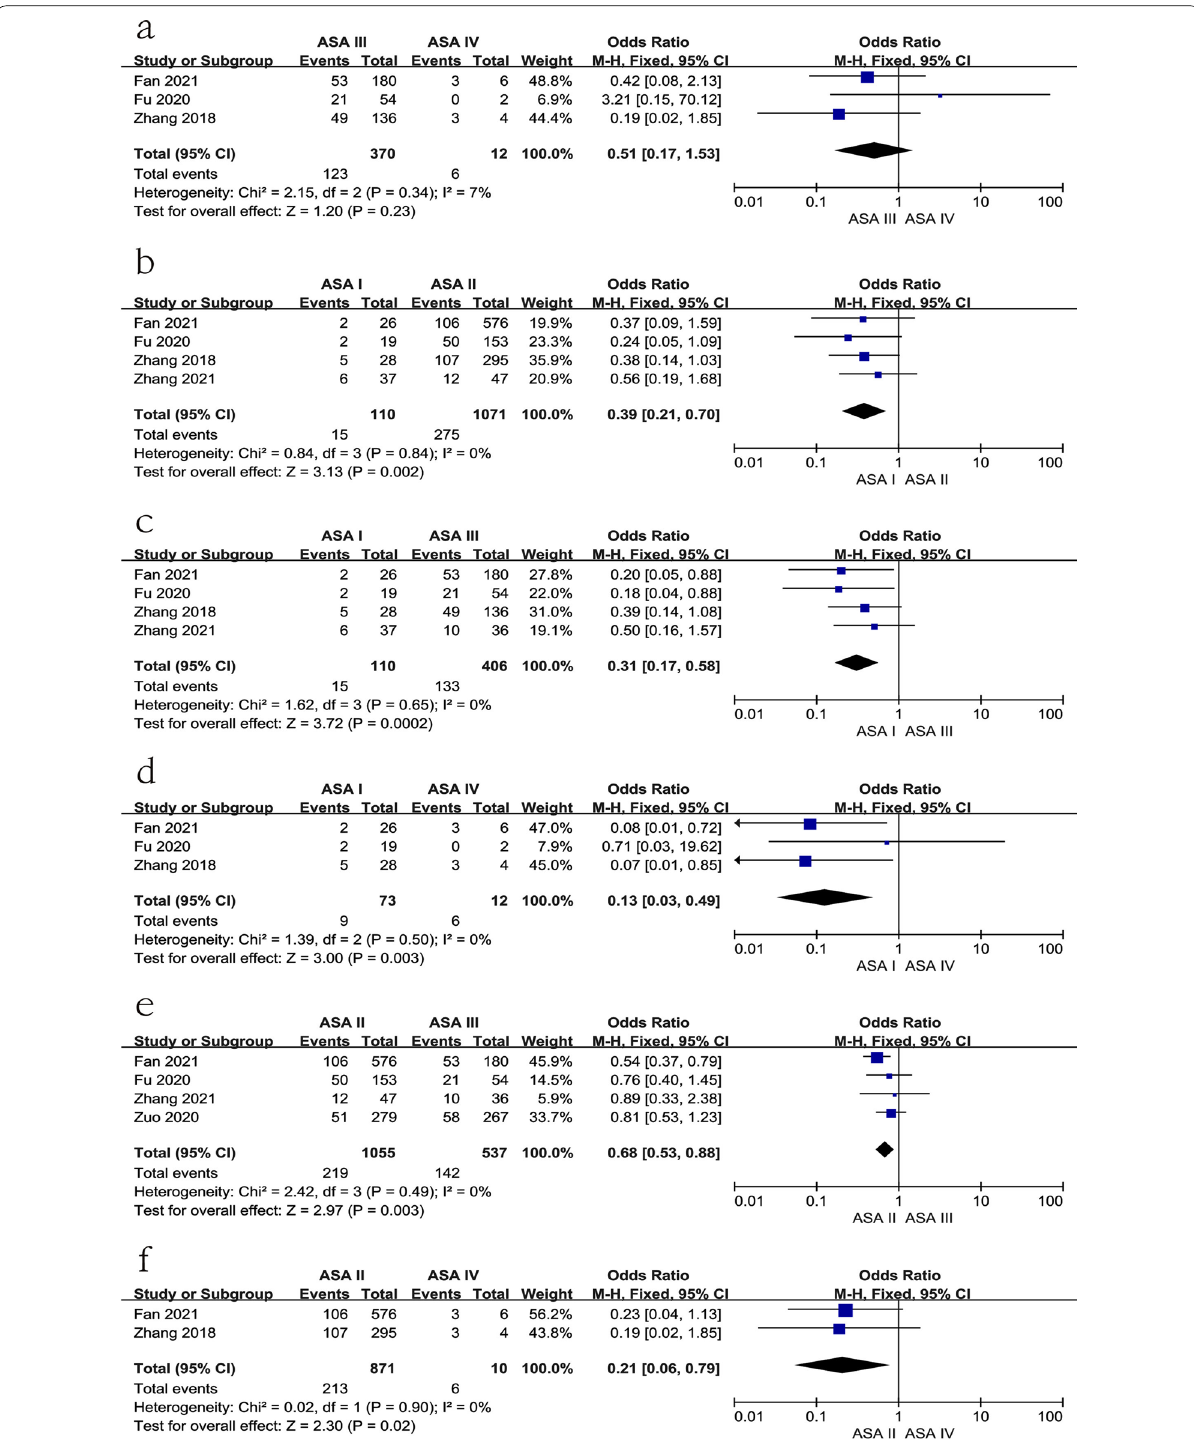
Fig. 14 Forest plot showing ASA class in 2 groups. CI confidence interval, df degrees of freedom, M-H Mantel–Haenszel. a ASA III and ASA IV; b ASA I and ASA II; c ASA I and ASA III; d ASA I and ASA IV; e ASA II and ASA III; f ASA III and ASA